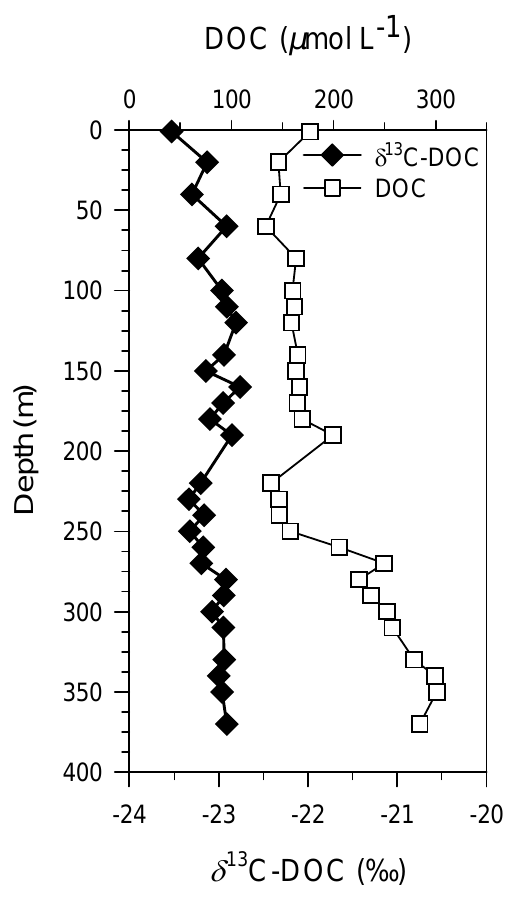
Figure 3. Depth profile from the lake surface to the lake floor of the dissolved organic carbon (DOC) concentration (µmolL − 1 ) and the δ 13 C signature of the DOC pool, in September 2012. The white dashed line represents the vertical position of the oxic–anoxic tran- sition.